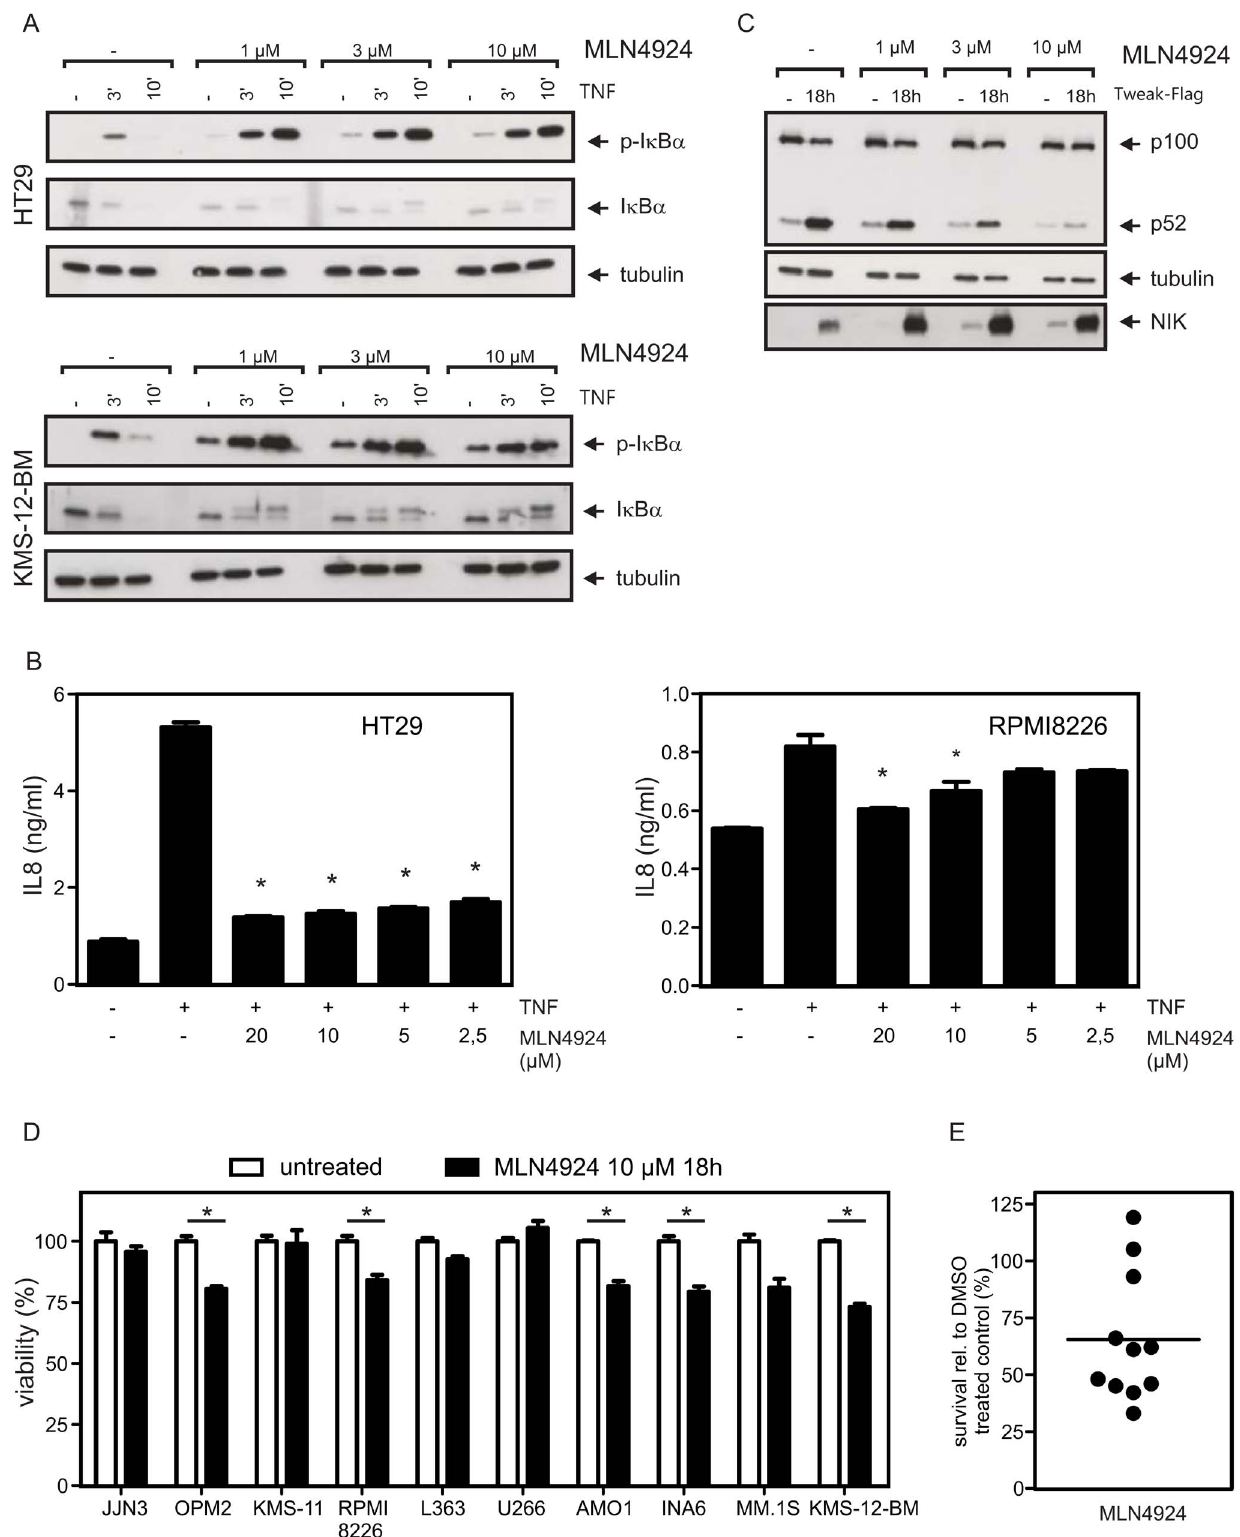
Figure 4. Functional titration of MLN4924 and effects on MM cell viability. (A) HT29 and KMS-12-BM cells were pretreated for 1 h with the indicated concentrations of MLN4924 and challenged with TNF (50 ng/ml) for 3 and 10 min. Phosphorylation and degradation of I k B a were subsequently analyzed by Western blotting of total cell lysates. (B) HT29 cells (20,000/well, 96 well-plate, triplicate values) and RPMI8226 cells (50,000/ well, 96 well-plate, triplicate values) were pretreated for 30 min with different concentrations of MLN4924. Cells were then stimulated with 100 ng/ml TNF for 6 h and the IL8 content of supernatants was determined by ELISA. For statistical analysis a one-way ANOVA with a Tukey post-test was